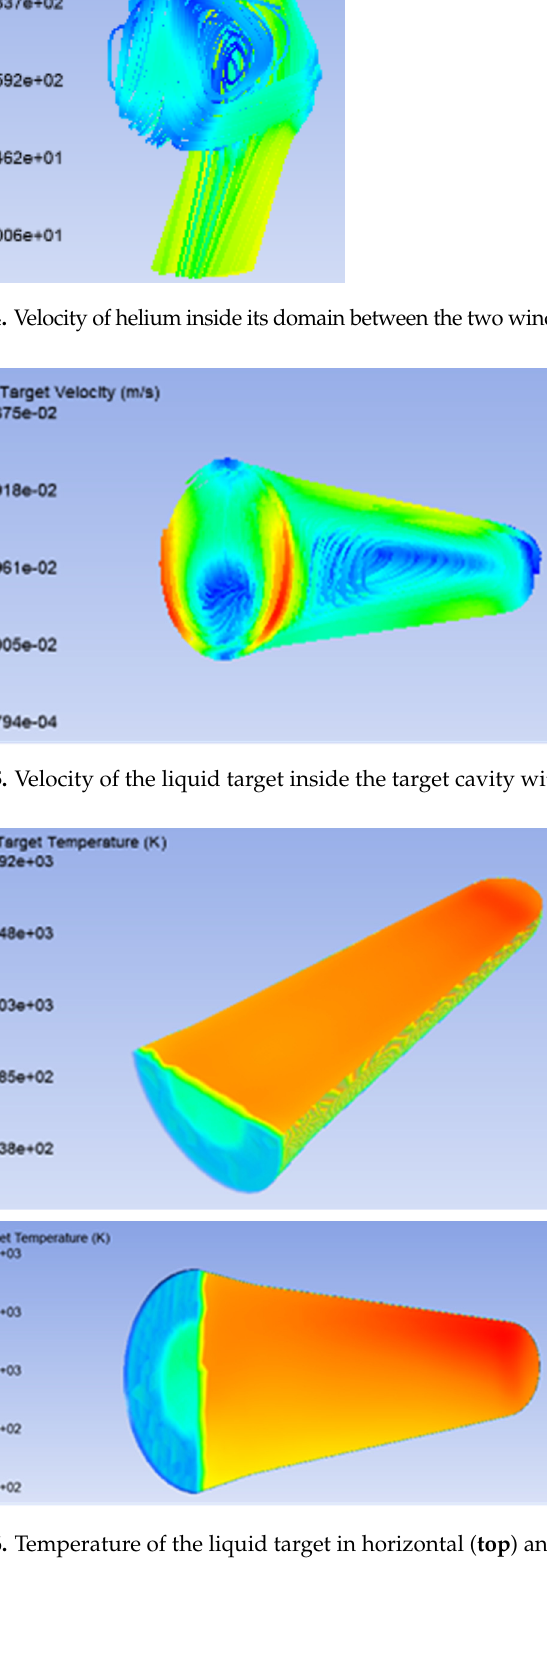
Figure 6. Temperature of the liquid target in horizontal ( top ) and vertical ( bottom ) cuts.